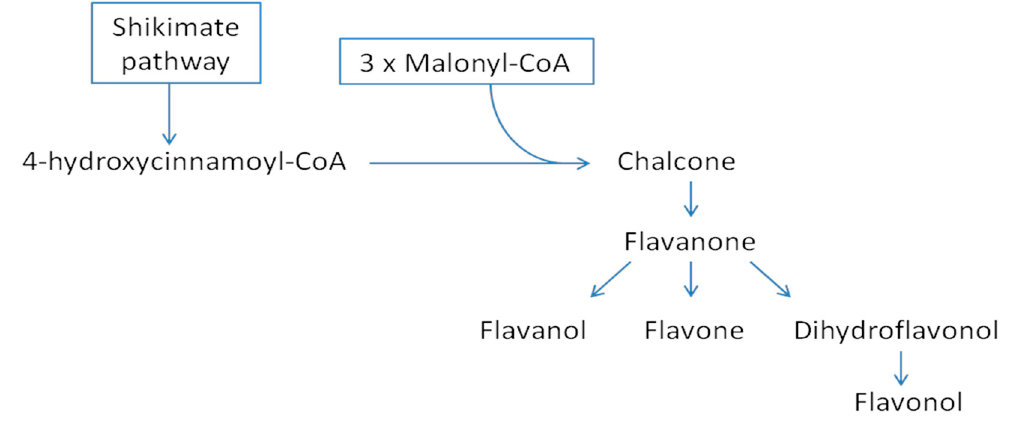
Figure 1. Scheme of the flavonoid biosynthetic pathway [16].